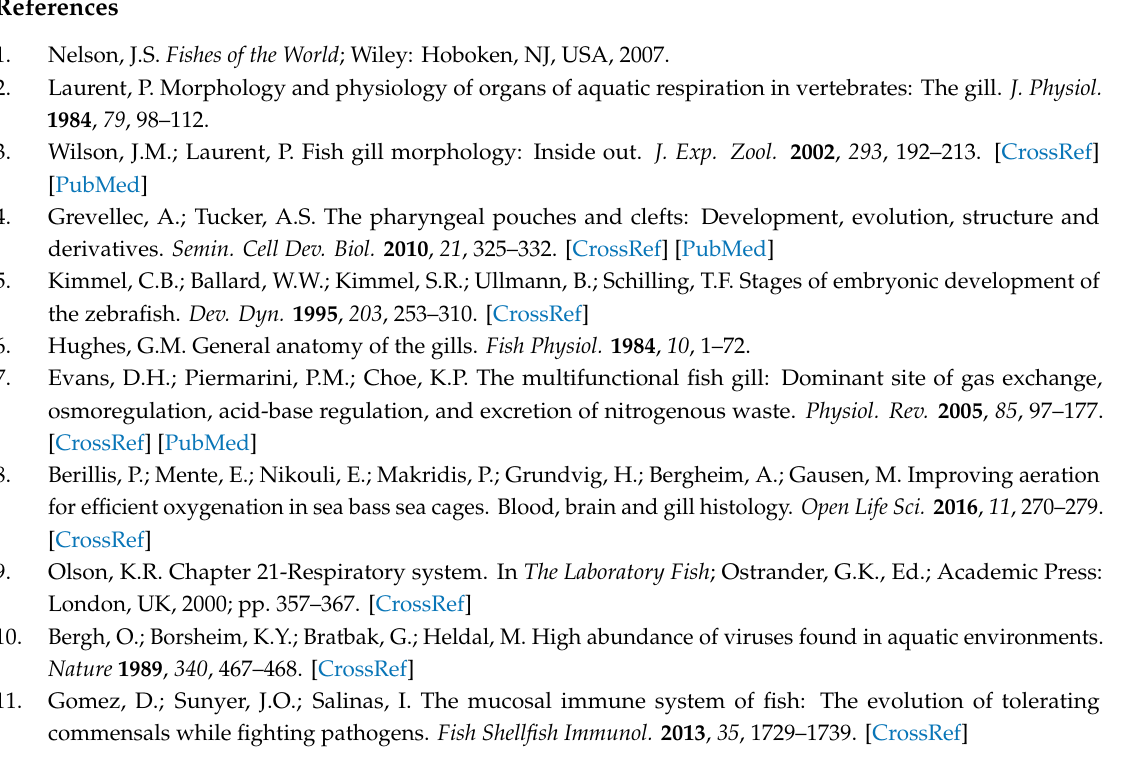
Table S1. Origin of samples and numbers of individuals; Figure S1: Gill-associated lymphoid tissue (GIALT) or interbranchial lymphoid tissue (ILT) of various teleost